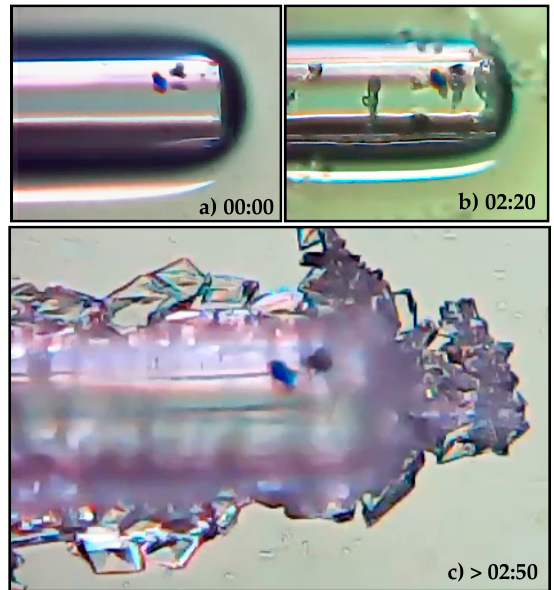
Figure 6. Crystallization process of paracetamol (video online) a) Liquid paracetamol solution in contact with the MMF-tip sensor, b) beginning of the paracetamol crystallization with continuous exposure to air and c) full evaporation of the liquid solution and formation of crystalline structures of paracetamol.